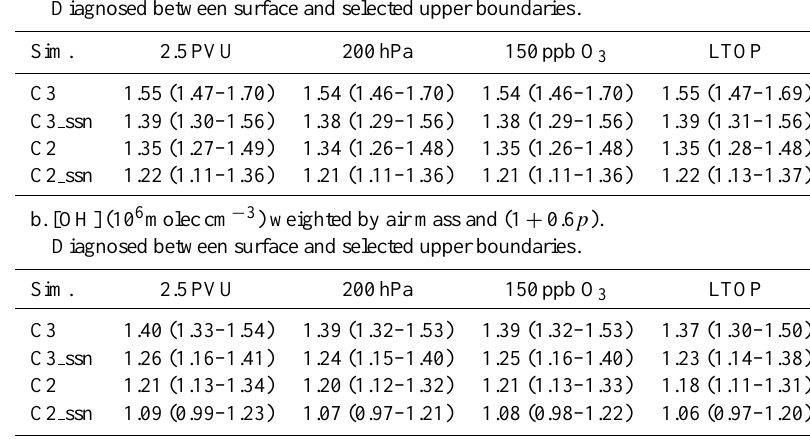
Table 3. Annual average of OH in the atmosphere, calculated from monthly means of OH, air mass, temperature ( T ) and pressure ( p , in bars), for the air mass below the model PVU-based tropopause height, air mass below 200hPa, air mass below the modelled 150ppbO 3 surface, and the air mass in the whole model domain (up to top level LTOP). The average OH concentration is weighted by air mass and by (a) the loss rate of CH 4 (exp( − 1775/ T )) and (b) the approximate loss rate of CO (1 + 0.6 p ). All numbers are for the year 2005, and the ranges of monthly means are given in parentheses.